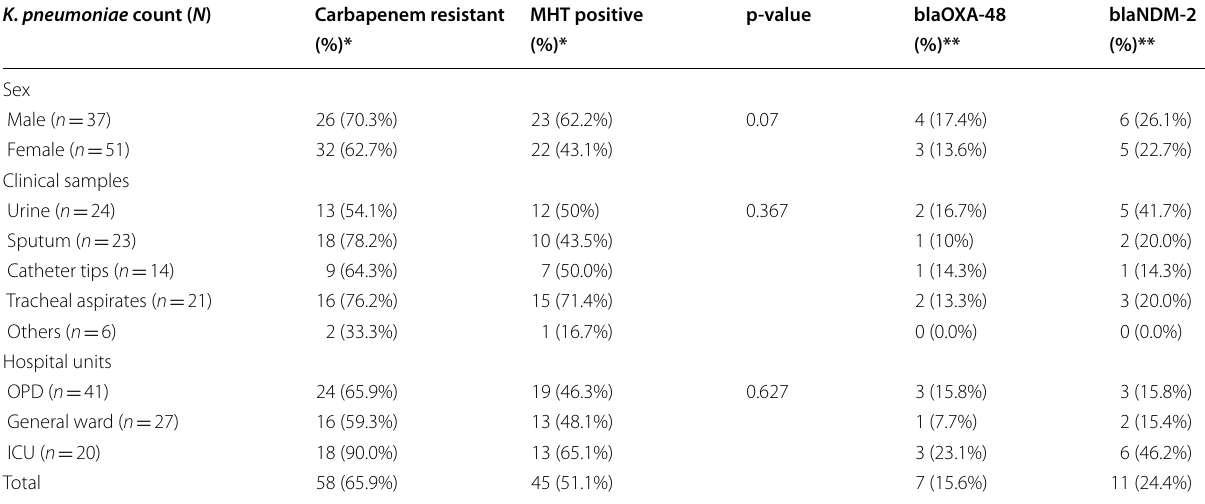
*Denotes percentages were calculated on K. pneumoniae count and **denotes percentages were calculated on MHT-positive K. pneumoniae